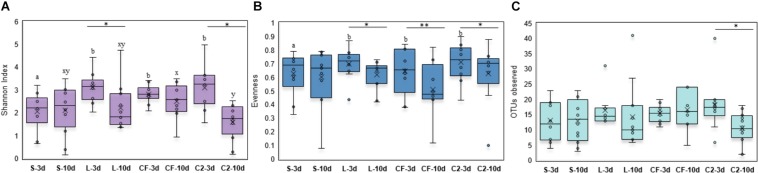
Alpha-diversity indices measured by (A) Shannon index, (B) Evenness, and (C) OTUs observed in upper ileum samples treated with either saline (S), LAB-probiotic (L), Citrobacter freundii (CF) or Citrobacter spp. (C2). Superscripts at the top of each index represent significant differences between treatments at 3 (a,b) and 10 days of age (x,y). Comparisons over time of collection within a treatment were reported with (∗) indicating significance at level P < 0.05 and (∗∗) a trend of significance (P = 0.056).